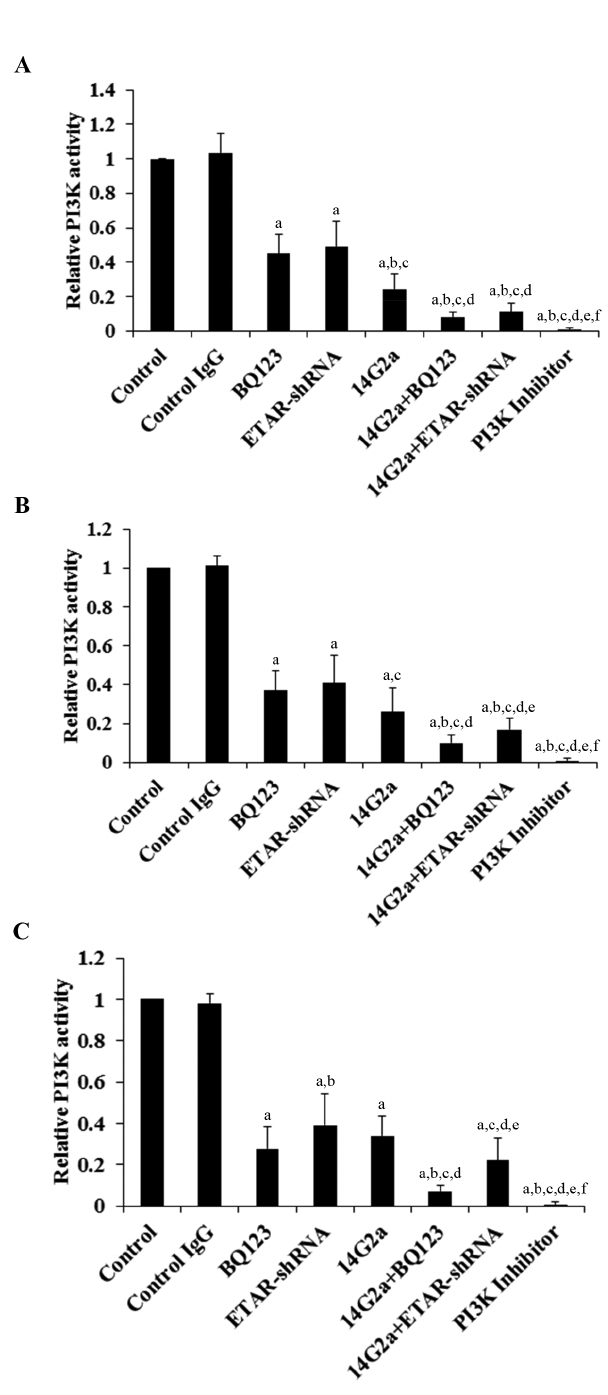
Figure 7. Effects of anti-ganglioside GD2 14G2a monoclonal antibody (mAb) alone or in combination with ET A receptor (ETAR) antagonist on phosphatidylinositide 3-kinase (PI3K) activity in osteosarcoma (OS) cells. PI3K activities were determined with a PI3K Activity ELISA kit (Echelon Biosciences) in Saos-2 ( A ), MG-63 ( B ) and SJSA-1 ( C ) OS cells treated with control IgG (PK136 mAb, 50 m g/ mL), 14G2a mAb (50 m g/mL), selective ETAR antagonist BQ123 (5 m M), and 14G2a (50 m g/mL) + BQ123 (5 m M) for 48 hours. Cells with knock- down of ETAR (ETAR-shRNA) with or without 14G2a mAb treatment were also tested. Cells treated with selective phosphatidylinositide 3-kinase (PI3K) inhibitor BKM120 (50 m M) was used as a positive control. The PI3K activity was shown as fold changes to that of the untreated control cells (designated as 1). Each experiment was repeated for three times in duplicates. Data values were expressed as Mean + SD. a p ,